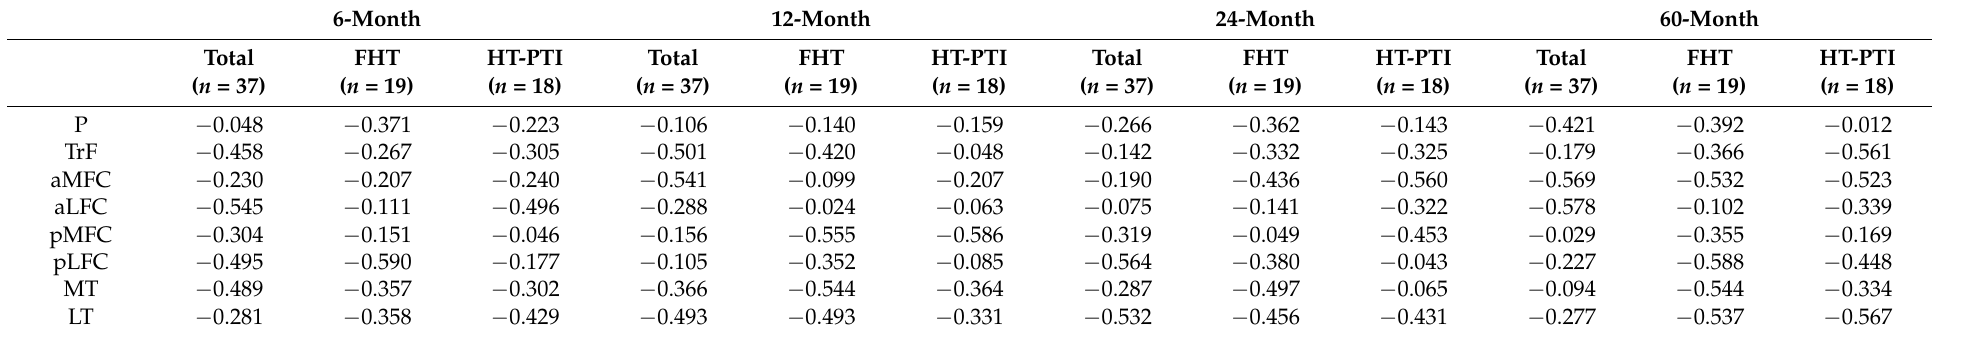
Table A3. Correlation between value CV% and T2 value of each cartilage sub-region after operation ( r